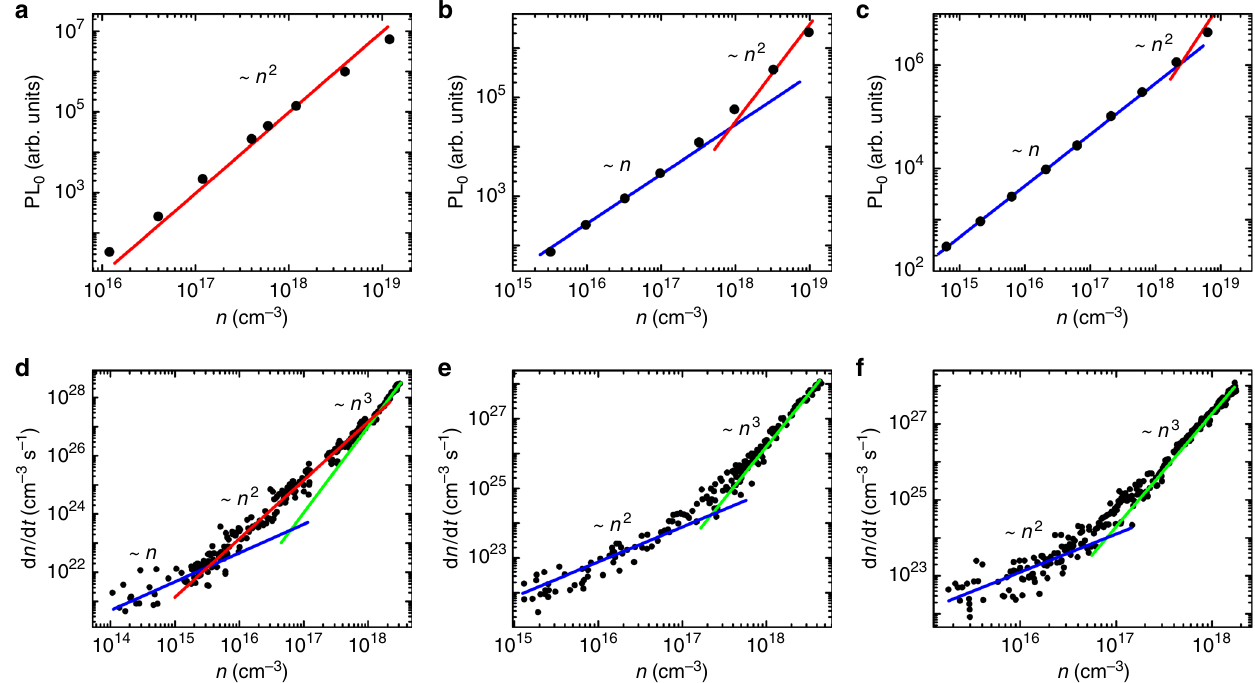
Fig. 4 Radiative recombination in the perovskite fi lms. PL intensity immediately after photoexcitation (PL 0 ) (400 nm wavelength, 50 fs pulse width) plotted against optical excitation density ( n ) for perovskite fi lms with a 0% PEABr, b 40% PEABr, or c 40% PEABr-crown. Recombination rate (d n/ d t ) plotted against n for perovskite fi lms with d 0% PEABr, e 40% PEABr, or f 40% PEABr-crown. Blue, red, and green lines are guides for the eye representing linear, quadratic, and cubic dependencies